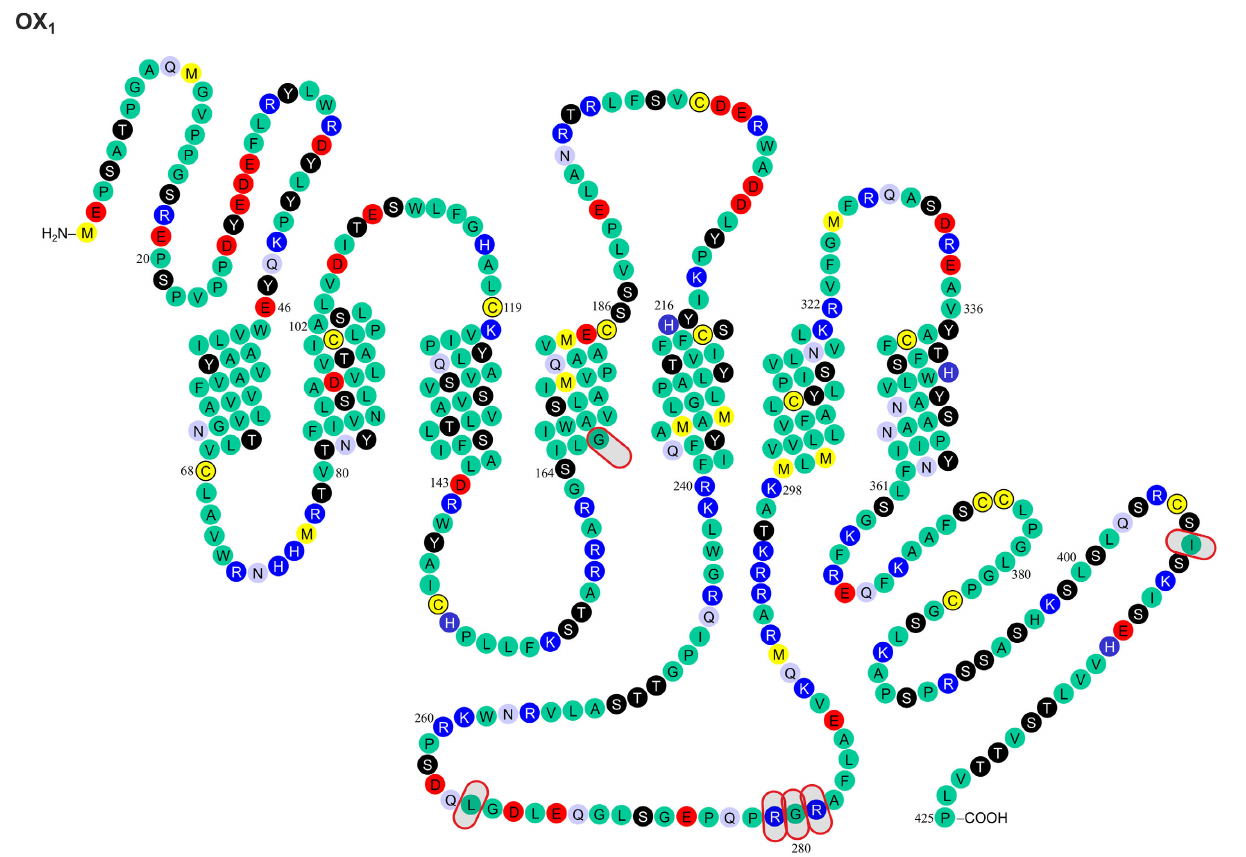
FIGURE 1 | Known amino acid sequence-changing variants of human OX 1 receptor. The variants are OX 1167 Gly/Ser, OX 1265 Leu/Met, OX 1279 Arg/Glu, OX 1280 Gly/Ala, OX 1281 Arg/His, OX 1408 Ile/Val, OX 210 Pro/Ser, OX 211 Pro/Thr, OX 2193 Cys/Ser, OX 2293 Ile/Val, OX 2308 Val/Ile, and OX 2401 Thr/Ile. The